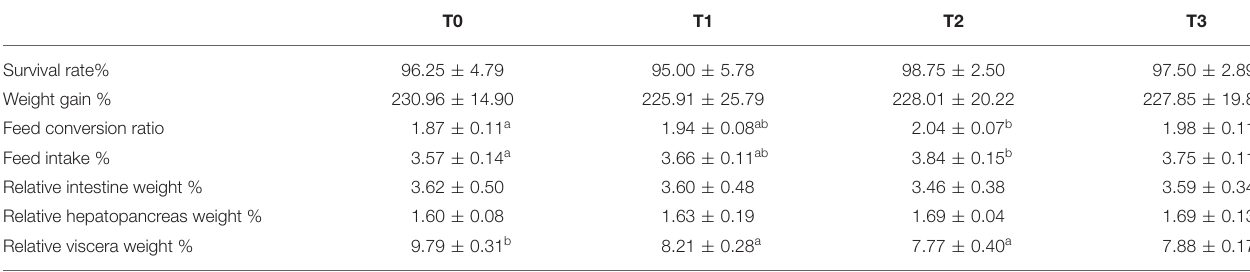
TABLE 3 | Survival and growth performance of grass carp (means ± SD, n = 4).